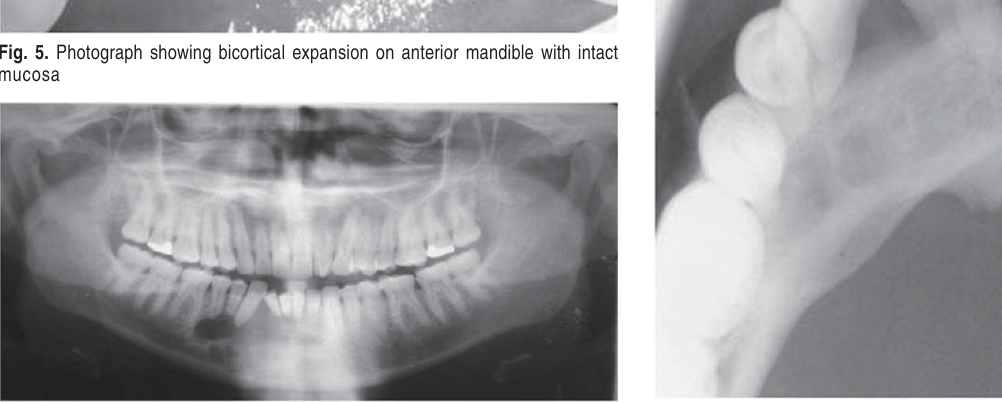
Fig. 7. Mandibular occlusal view showing thinning of buccal